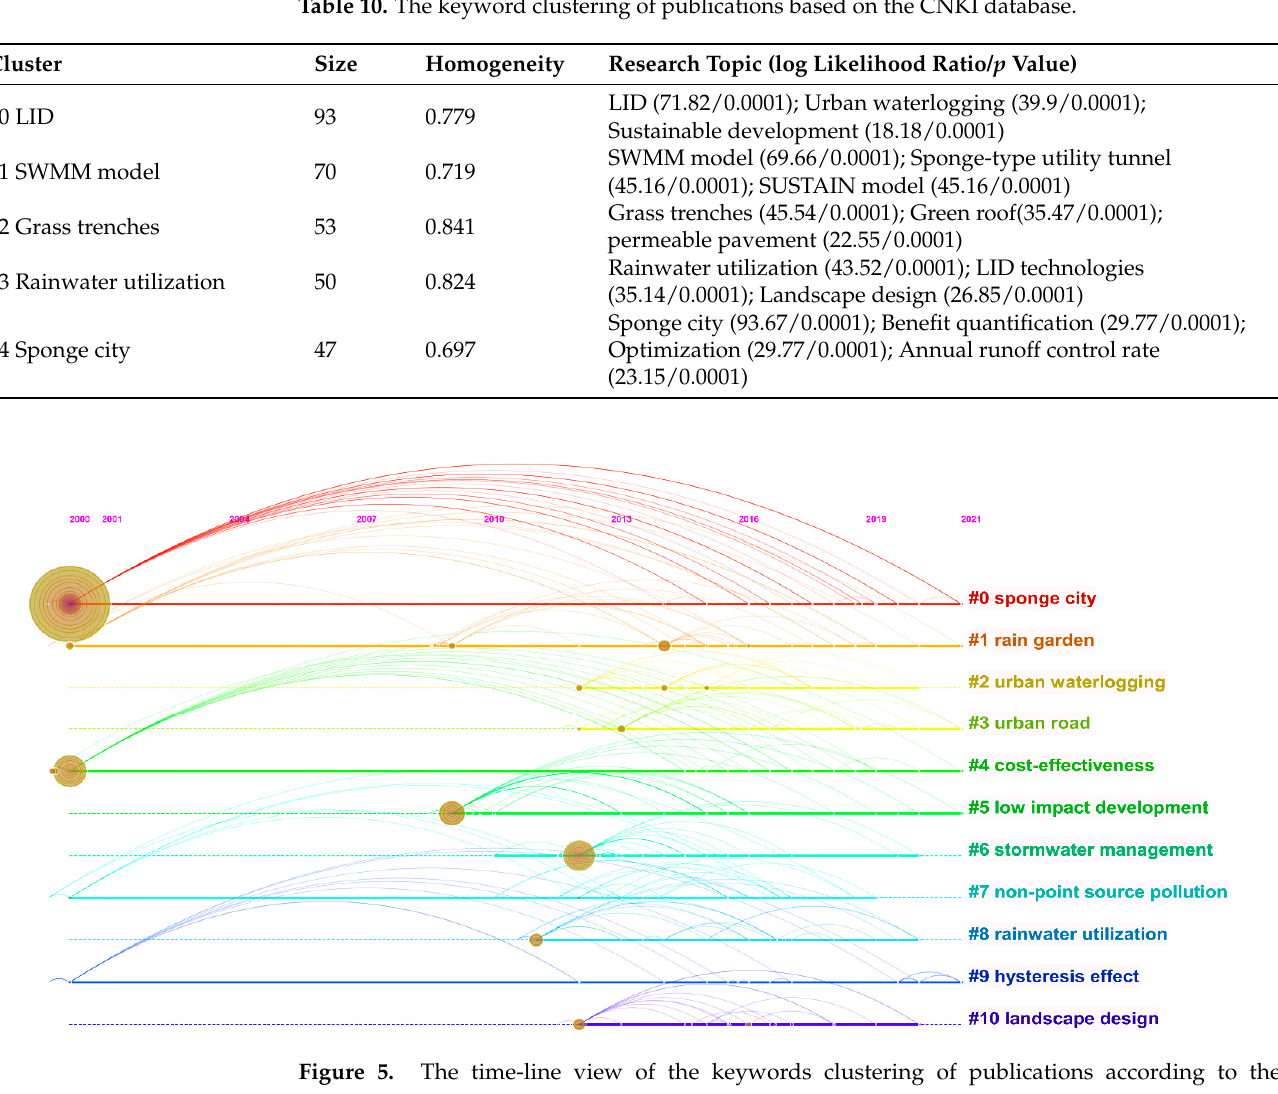
Table 10. The keyword clustering of publications based on the CNKI database.